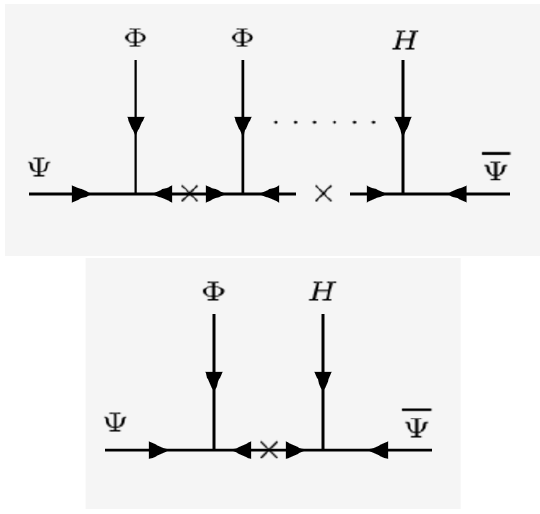
Figure 1 . A supergraph depiction of the corrections to the superpotential represented by eq. (2.1). An example for n = 2 involving a single Flavon insertion is given below. The internal lines are heavy messengers, and the cross denotes a supersymmetric mass insertion M